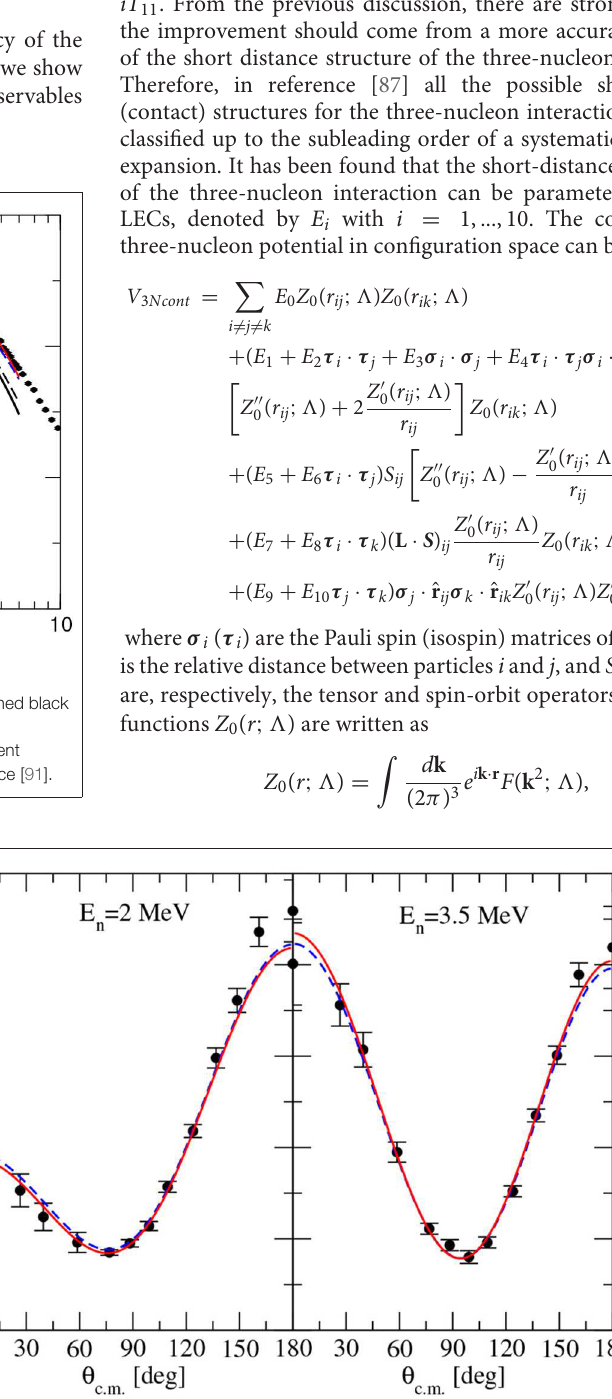
Frontiers in Physics | www.frontiersin.org